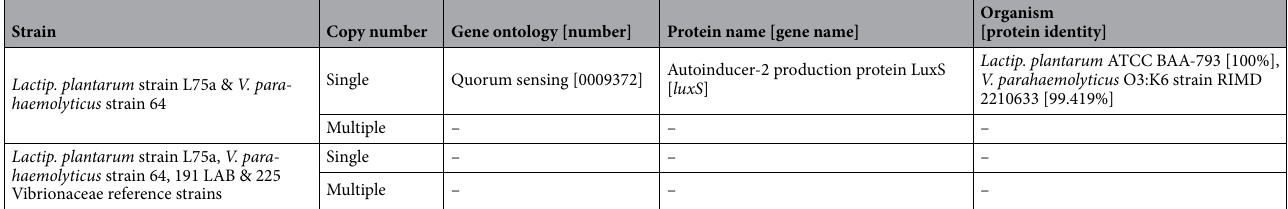
Table 1. The probiotic-pathogen shared gene orthogroups (genetic niche overlap) that might rationalize the benefit or detriment of the probiotic to the pathogen. Genome sequences of 191 LAB and 225 Vibrionaceae strains with complete genome level as indicated in NCBI database website, including all Lactip. plantarum , Lactococcus lactis , Lacto. garvieae , Weissella hellenica , Pediococcus pentosaceus , Leuconostoc pseudomesenteroides , V. parahaemolyticus , V. harveyi , V. campbellii , V. rotiferianus , V. alginolyticus , V. cholerae , V. anguillarum , V. vulnificus and Photobacterium damselae , were downloaded from RefSeq database 18 and used as reference sequences. After orthogroup inference, functional gene annotation, and preclusion of those related to regular basic biological processes, the sole remaining shared gene orthogroup possessed by both Lactiplantibacillus 17 and Vibrio is related to quorum sensing. ‘–’ indicates not available. Shared gene orthogroups with protein identity lower than 90% are not shown.